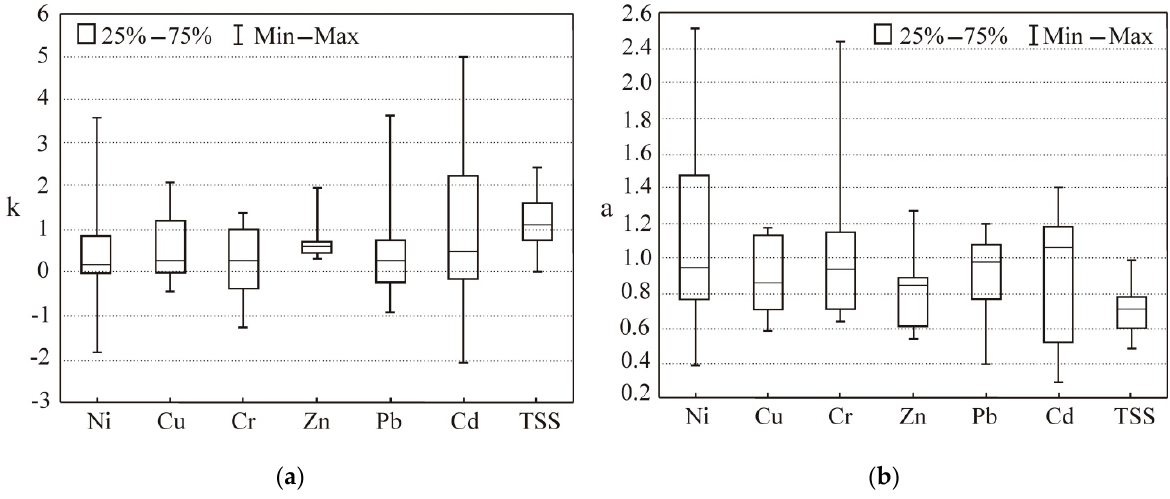
Figure 5. The range of variation in washout coefficients: ( a ) coefficient ( k ); ( b ) coefficient ( a ).